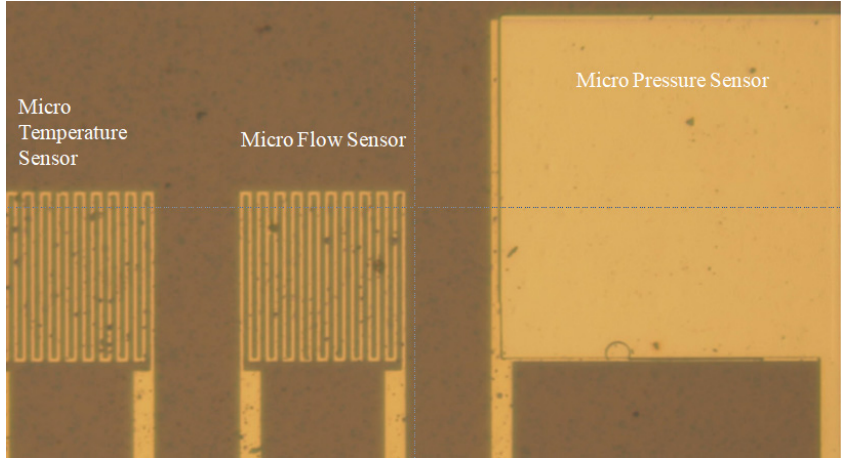
Figure 2. Optical microscope image of a three-in-one flexible micro-sensor.